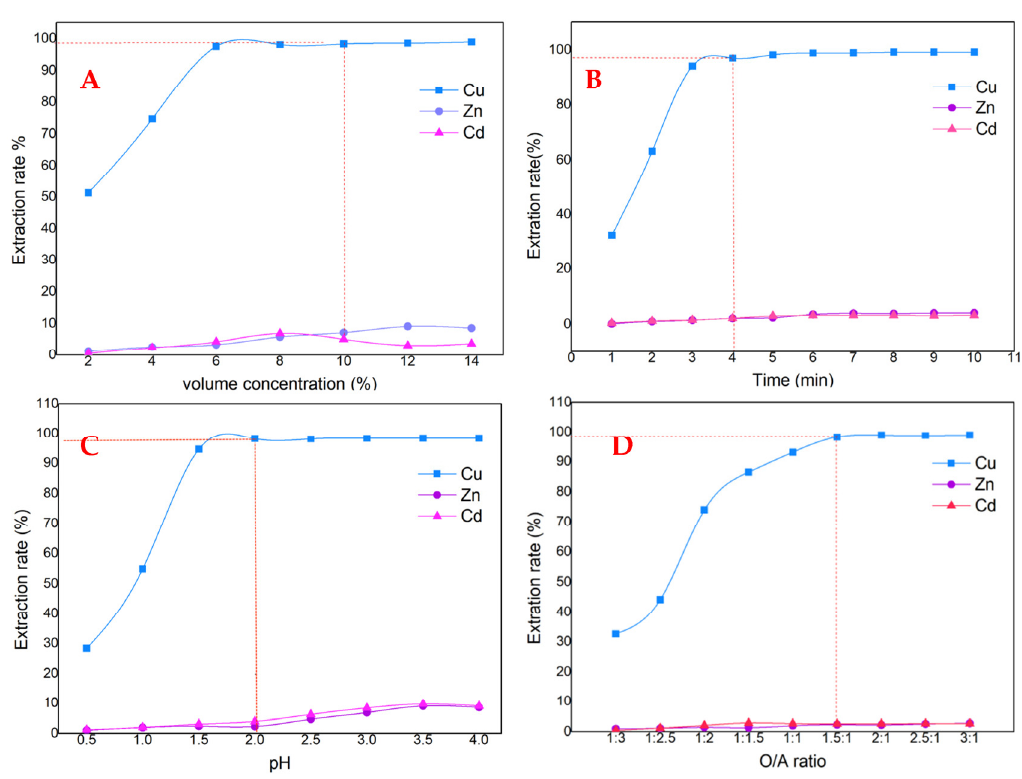
Figure 2. The main influencing parameters of copper removing testing ( A ) reaction time, ( B ) volume fraction, ( C ) Oil phase/Aqueous phase(O/A) ratio, and ( D ) initial aqueous phase pH.